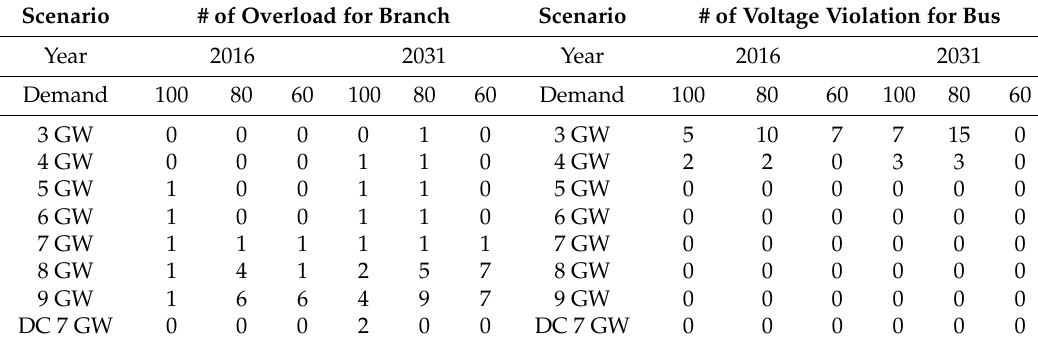
Table 5. The number of overloads and voltage violations for power flow